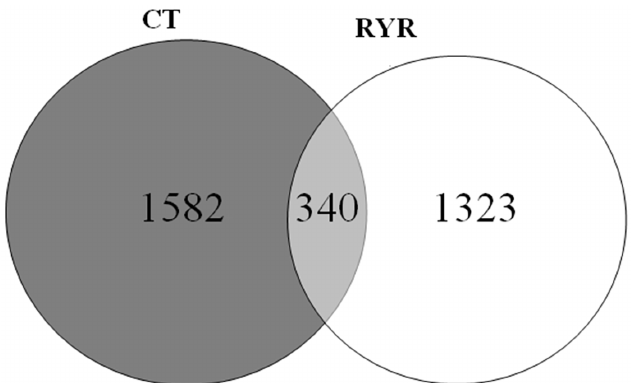
Fig 1. Venn plot showing the shared and unique Operational Taxonomic Units (OTUs) found in RYR group and CT group (n = 20).